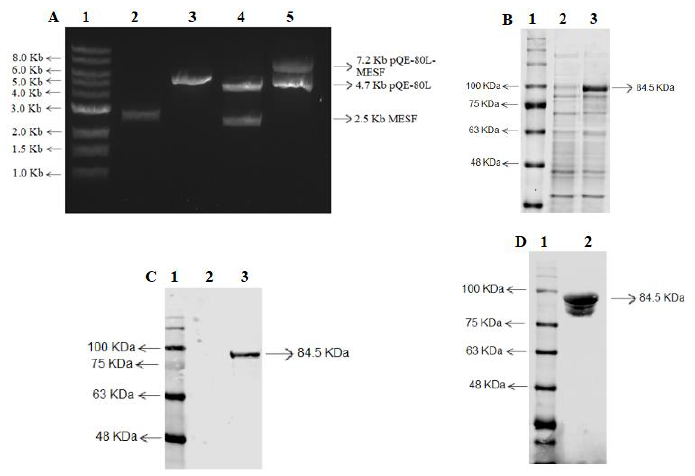
Figure 2. Cloning of chimeric gene (MESF), expression and purification of the recombinant multiepitope protein (rMESF). ( A ) Cloning of the MESF gene in pQE-80L expression vector with T4 ligase. Lane 1: 1 kb DNA ladder. Line 2: MESF gene. Line 3: pQE-80L. Line 4: product digestions of pQE-80L-rMESF with Sma I and Kpn I after ligation. Line 5: full circular size of pQE-80L-rMESP ( B ). SDS–PAGE of the expressed rMESF in E. coli BL21 cells after the induction with 1 mM IPTG for 4 h at 37 ◦ C. Line 1: molecular mass marker. Line 2: protein before induction with IPTG. Line 3: proteins after induction with IPTG showing the rMESF protein with 84.5 kDa. ( C ) Western blot confirming the expression of rMESF after the induction with IPTG. ( D ) Western blot confirming the presence of rMESF protein after the purification-elution by Ni-NTA a ffi nity chromatography. IPTG, isopropylthiogalactoside; SDS–PAGE, sodium dodecyl sulfate–polyacrylamide gel